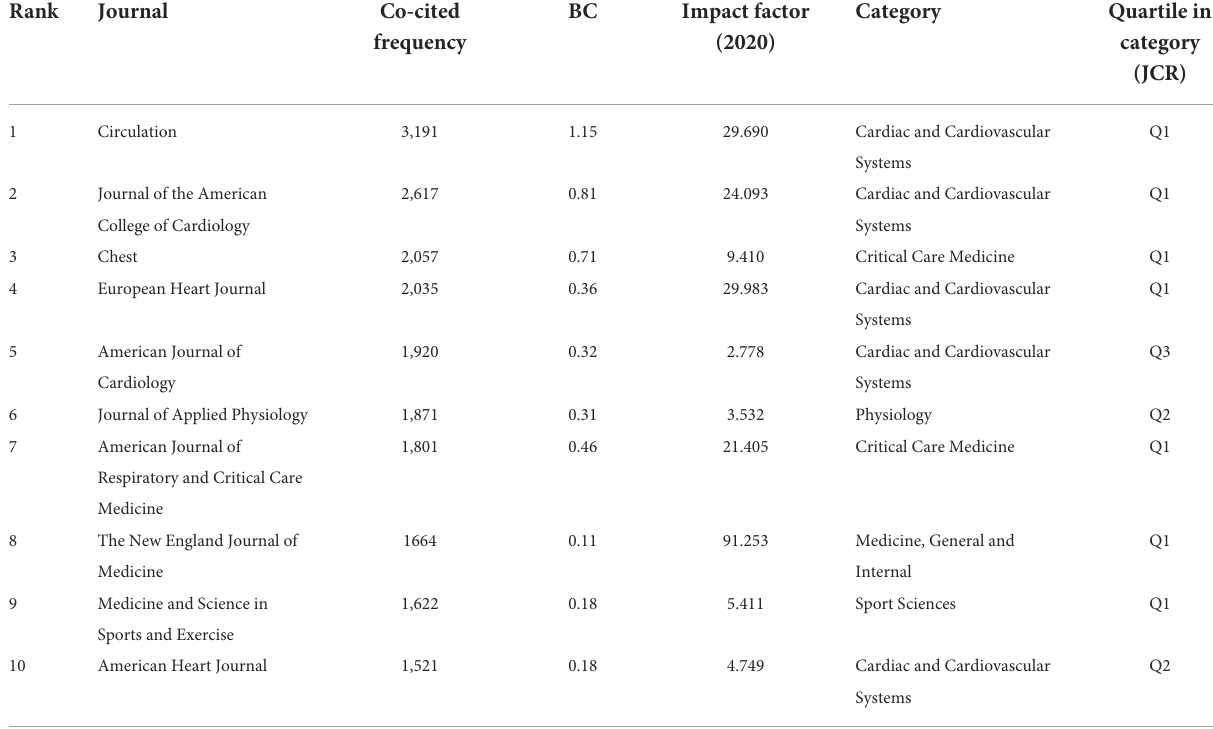
TABLE 6 Top 10 journals ranked by co-cited frequency on CPET